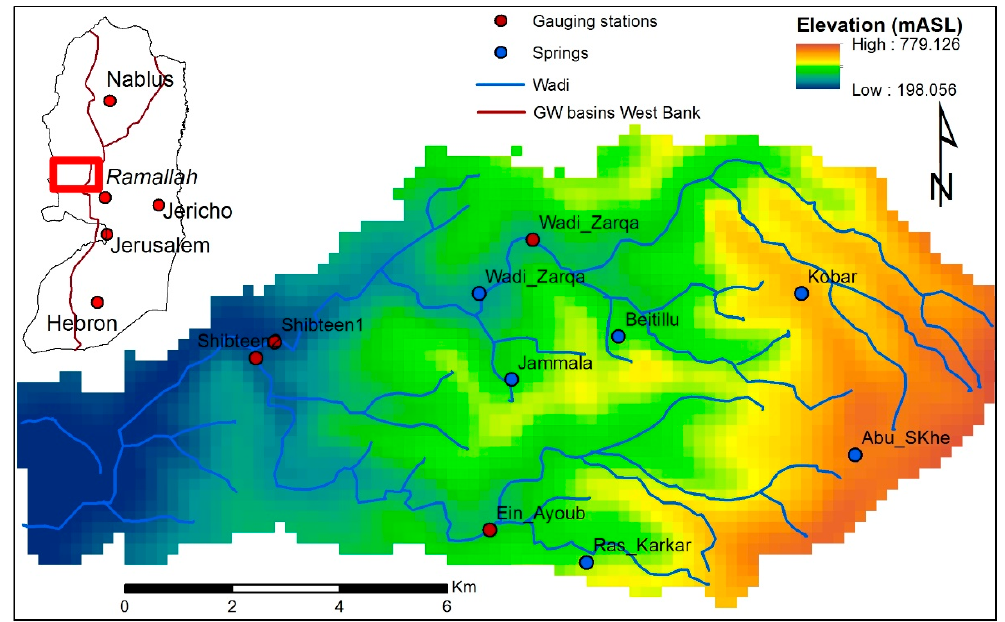
Figure 1. Location map of the Wadi Natuf catchment and topography of the catchment and location of the main spring groups.